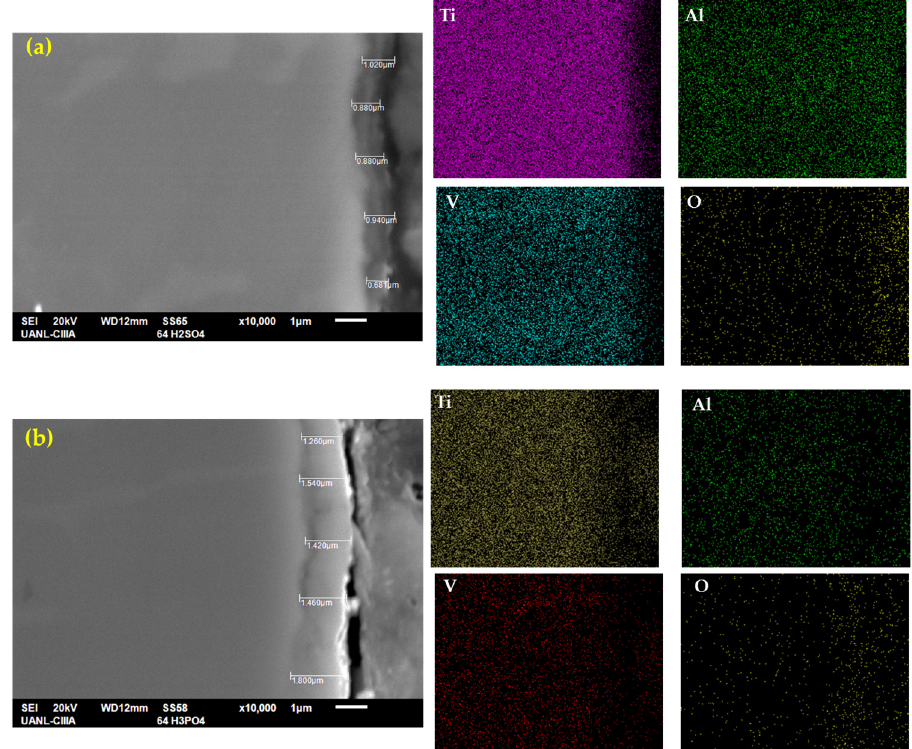
Figure 4. SEM-SEI of the cross-section of Ti-6Al-4V in ( a ) H 2 SO 4 and ( b ) H 3 PO 4 ; the elemental mapping by SEM identified Ti, Al, V, and O.